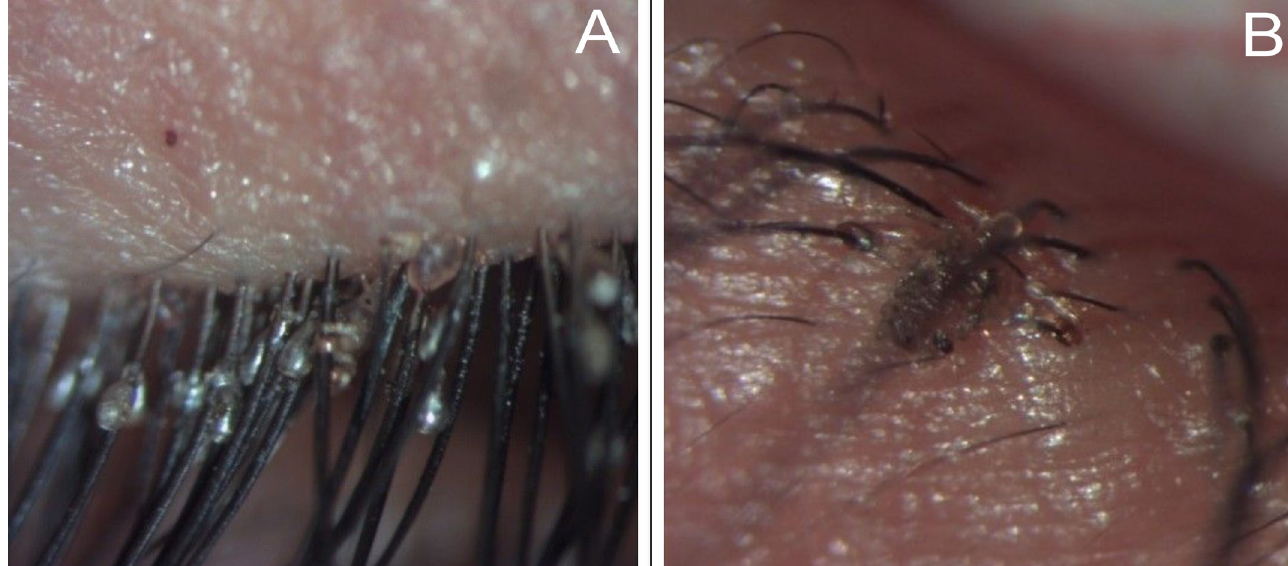
Fig.1. A: Magnified view of multiple nits in right upper eyelid Figure. B: Magnified view of crab louse.